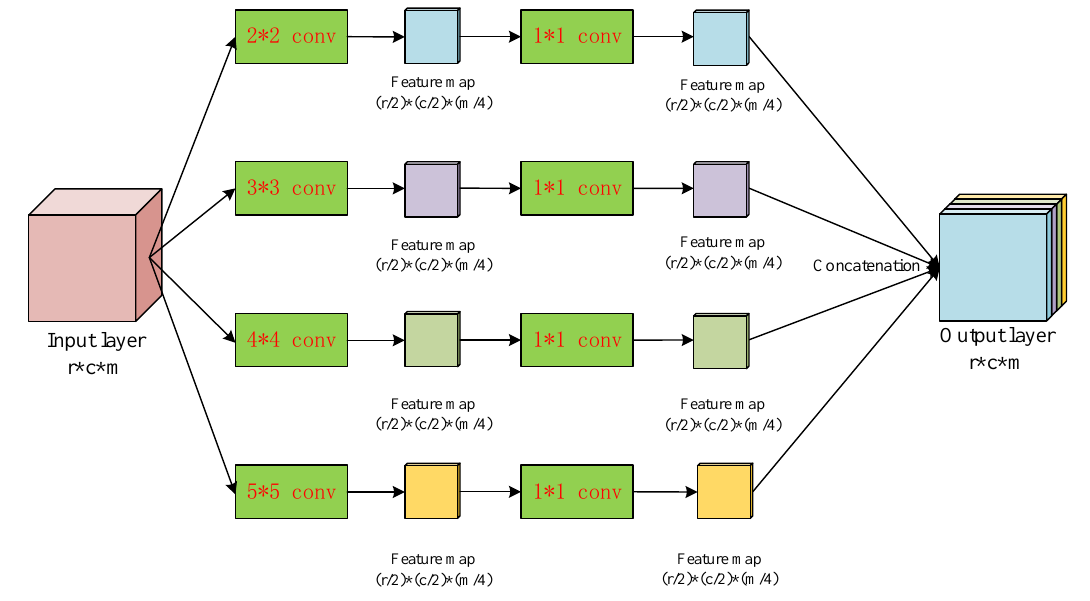
Figure 12. The multi-scale pooling block used in the proposed determination